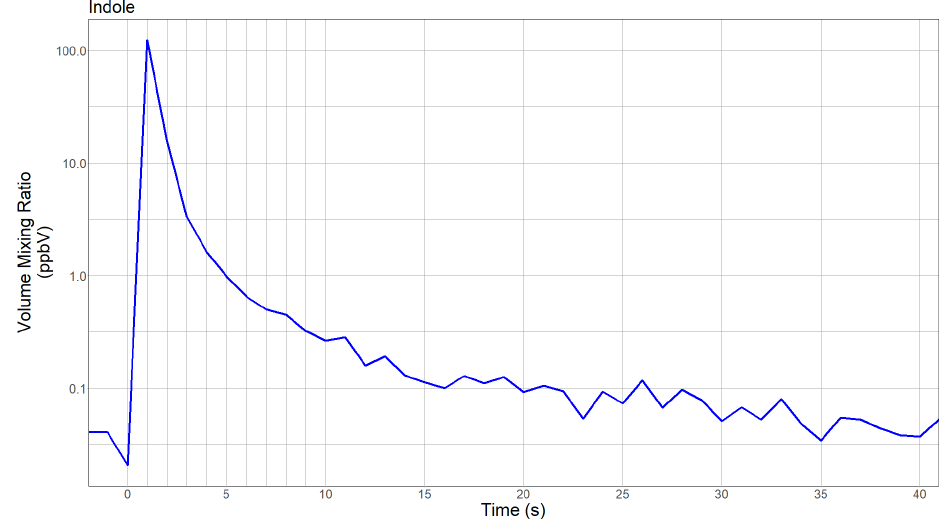
Figure 4. Time evolution of the observed indole volume mixing ratio (VMR) when the headspace from a vial containing indole was shortly blown towards the PTR-ToF-MS instrument in its field